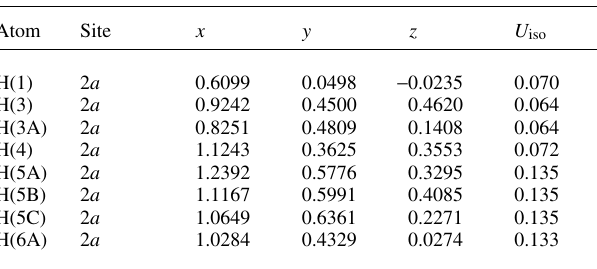
Table 2. Atomic coordinates and displacement parameters (in Å 2 )